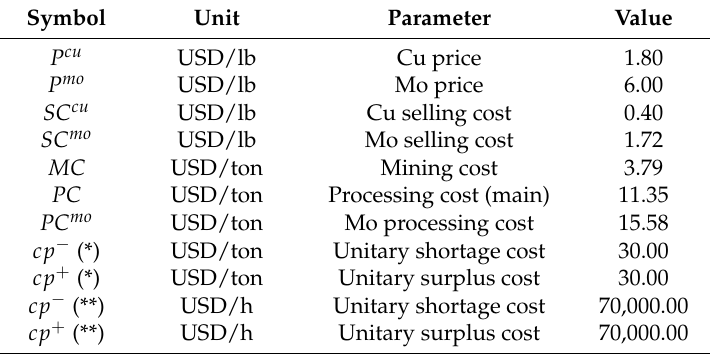
Table 3. Summary of economic parameters for block valuation applied in case study. Unitary costs to be considered: (*) scheduling Schemes 2 and 3; and (**) scheduling Scheme 4.